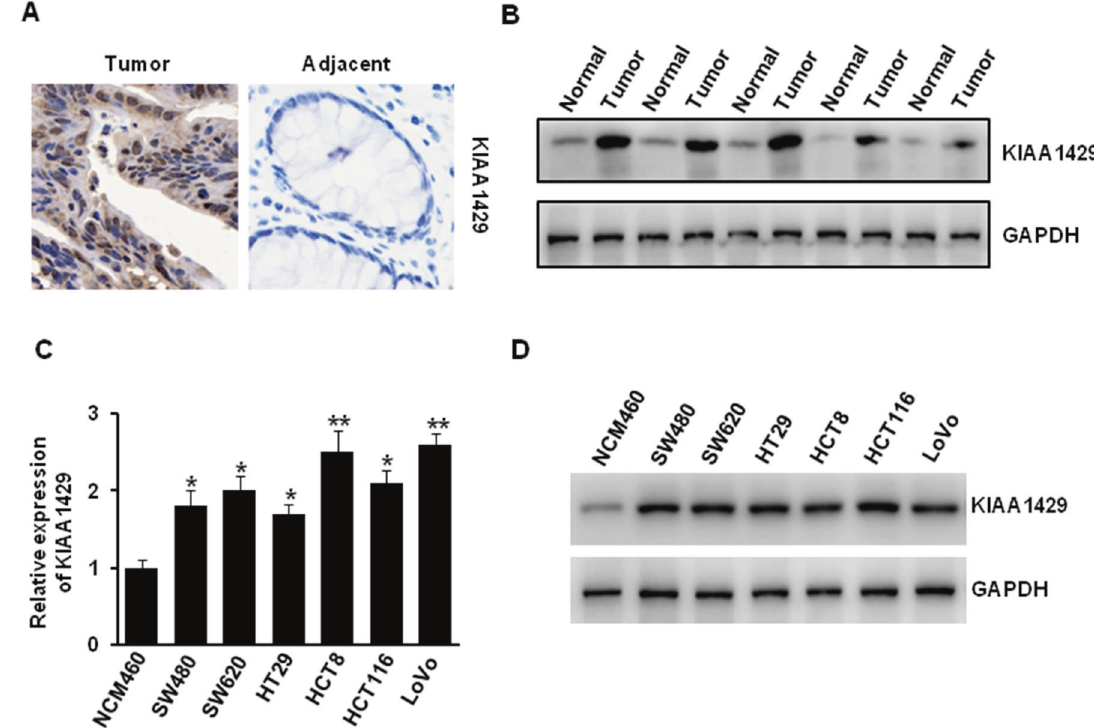
Fig. 2 KIAA1429 was upregulated in colorectal cancer cells. A IHC analysis of KIAA1429 in colorectal adenocarcinomas and adjacent tissues. B The protein level of KIAA1429 in human colorectal adenocarcinomas tissues and adjacent normal tissues. C , D The mRNA and protein level of KIAA1429 in human normal colon mucosal epithelial cell and colorectal cancer cell lines was detected by QRT-PCR ( C ) and western blotting ( D ). * P < 0.05, ** P <